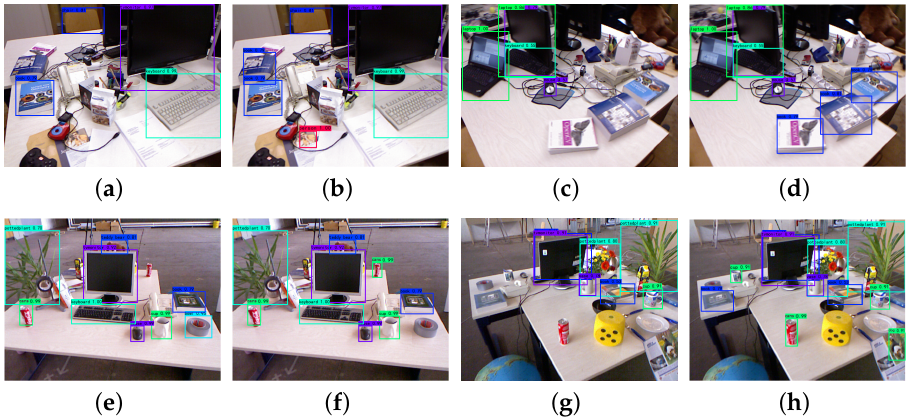
Figure 8. Detection results of TUM dataset using YOLOv3-Tiny and our method (v3). ( a , c , e , g ) show results of YOLOv3-Tiny; ( b , d , f , h ) shows results of our method